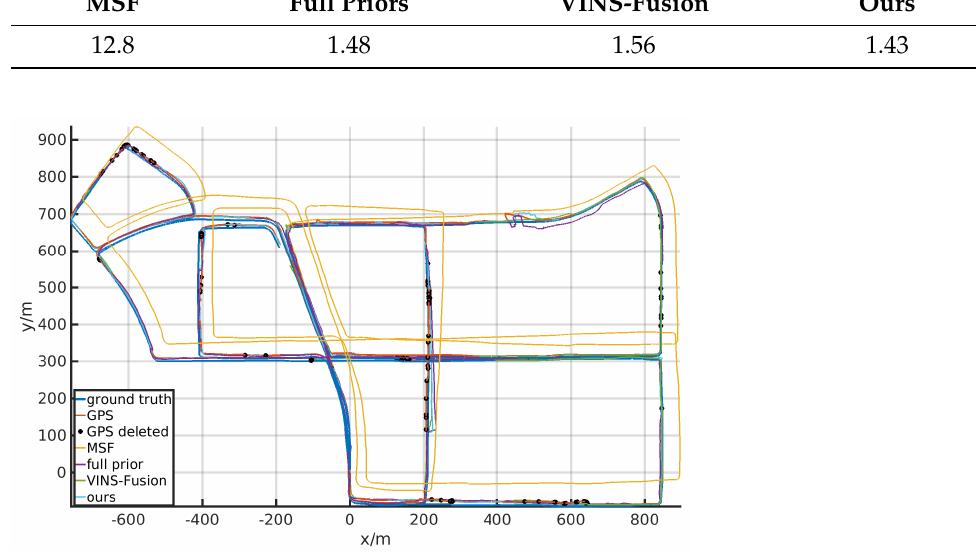
Figure 6. The localization trajectories of different localizers tested on Urban 38 of the KAIST dataset.